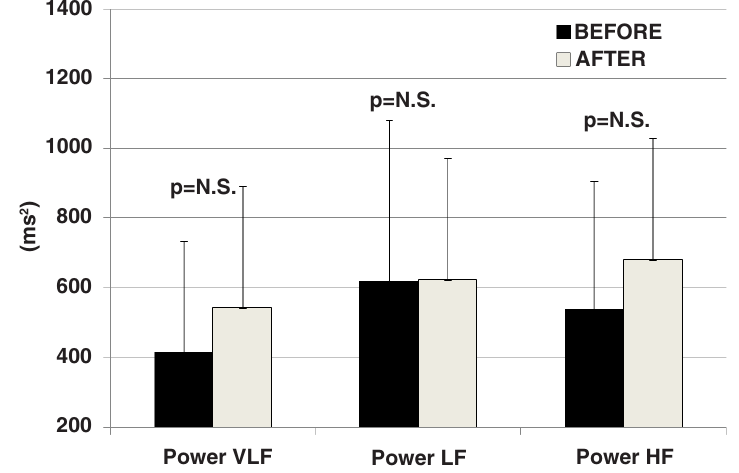
Figure 2. No sustained effects of a series of 4 treatments with Vanquish ® RF treatment on heart rate variability as assessed 39±18 days after the last treatment session. For description of spectral parameters see Figure